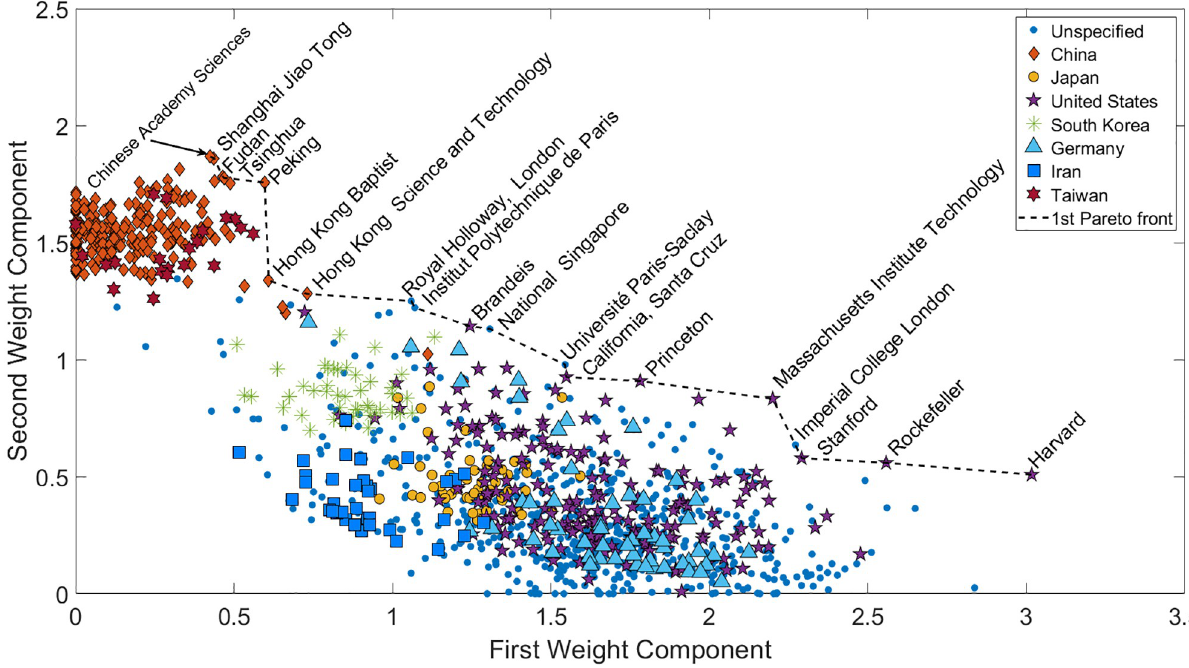
Fig 11. NMF-based Pareto front with scaled data as an input. Each indicator in the components is positively correlating with each other. Therefore there are no reverse objectives, only perpendicular ones. For this reason, the Pareto front is determined with the help of maximizing the objective functions. The NMF is applied to the scaled data before the Pareto front ranks the institutions. This method clusters the institutions into Eastern and Western cultures concerning education. The Chinese and Taiwanese universities are placed into a cluster on the left-hand side, while the European, American, and the remaining academies can be found on the right-hand side. South Korean and Iranian universities connect the two dominant scientific circles.